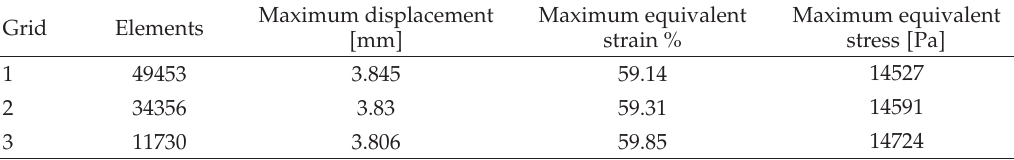
Table 3: Comparison of maximum displacement, strain, and stress for three di ff erent grid